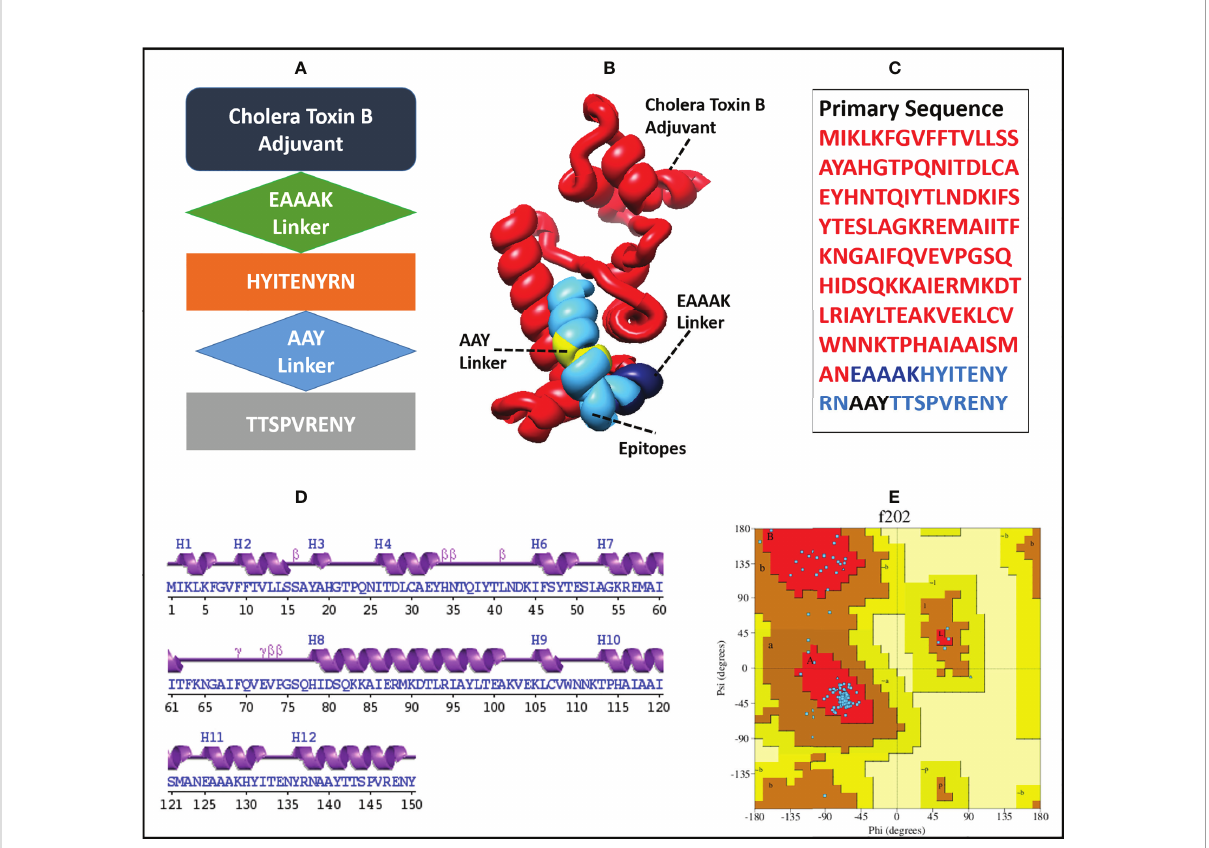
FIGURE 3 Diagrammatic illustration of the fi nalized MEMPV structural model; (A) a graphical representation of the arrangement of the selected epitopes, linkers, and adjuvant (B) Re fi ned three-dimensional structure of the MEMPV (Cholera Toxin B adjuvant in red color, EAAAK linker in navy blue, AAY linkers in yellow, and epitopes in deep sky blue color); (C) Primary sequence of vaccine construct; (D) Secondary structure characterization; (E) Ramachandran plot illustration of improved MEMPV design.